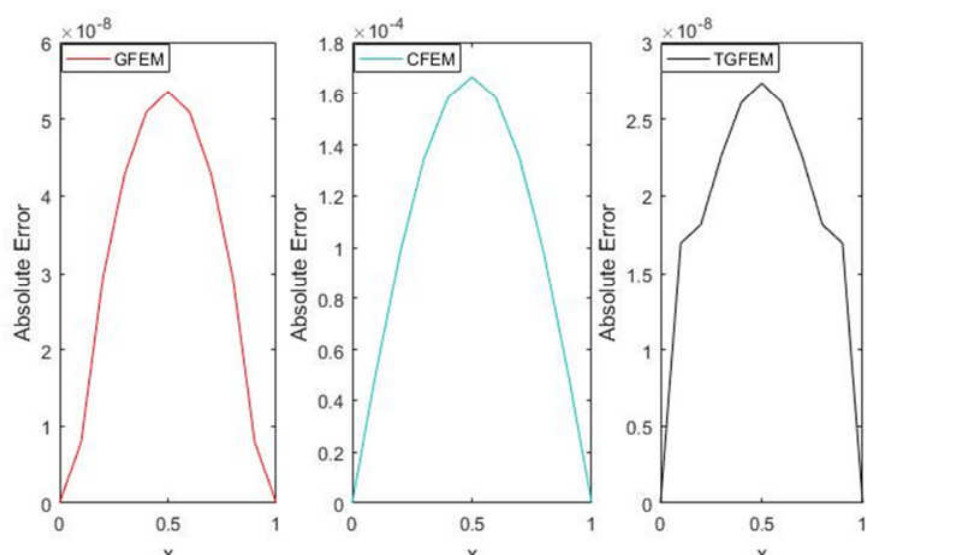
Figure 8 . Comparison of the currently suggested methods in terms of the absolute errors for (cid:14) (cid:2) 0.1 , (cid:10) (cid:2) 0.05,(cid:13)(cid:14) (cid:2) 0.001 , (cid:21) (cid:2) 0.1 , (cid:1) (cid:2) 0 and (cid:26) (cid:2) 1 in Problem